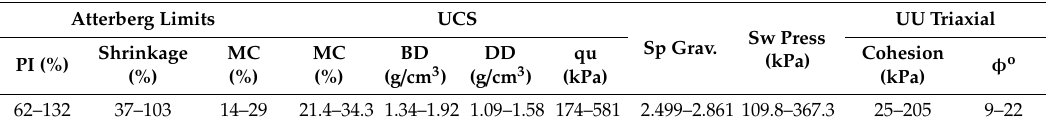
Table 3. Range of physical properties of bentonite from cores KM1, KM2, KM3 and